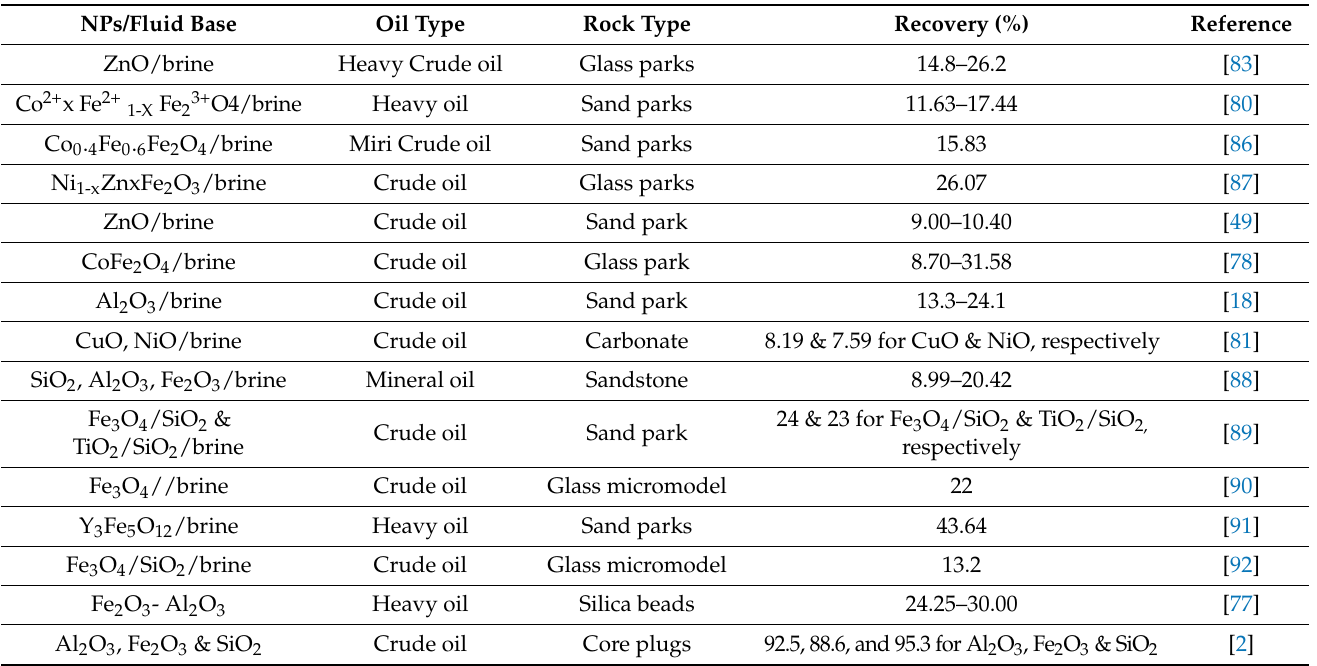
Table 2. Summary of the experimental analysis of nanofluids flooding for EM-assisted enhanced oil recovery. NPs/Fluid Base Oil Type Rock Type Recovery